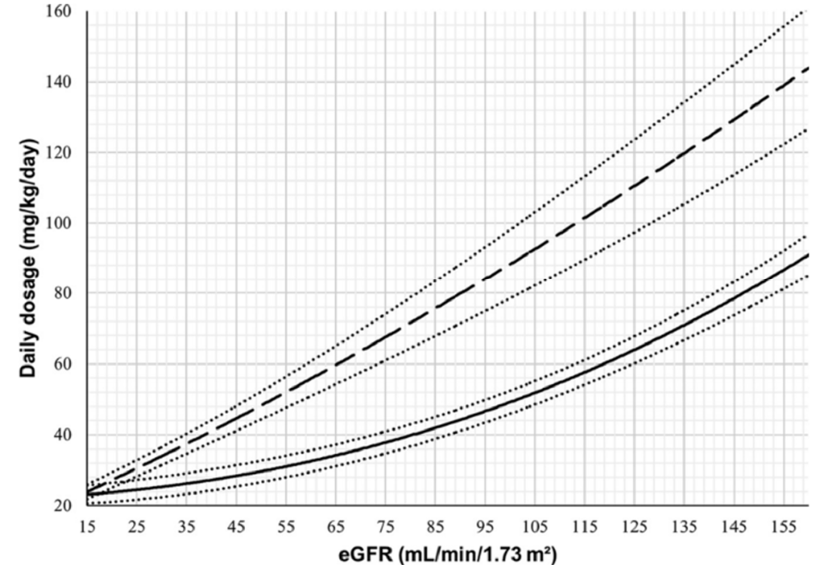
Figure 2. Nomogram of the daily dose of ceftriaxone per kilogram of total weight to be administered to achieve a trough concentration target of 20 mg/L (full line) and to not exceed 100 mg/L (broken line) with a probability of 0.9, accounting for renal function estimated by the CKD-EPI formula (eGFR) using a twice-daily regimen. Dotted lines represent the 95% confidence interval (used with permission from Antimicrobial Agents and Chemotherapy, License ID1286030-1, ISSN1098-6596)